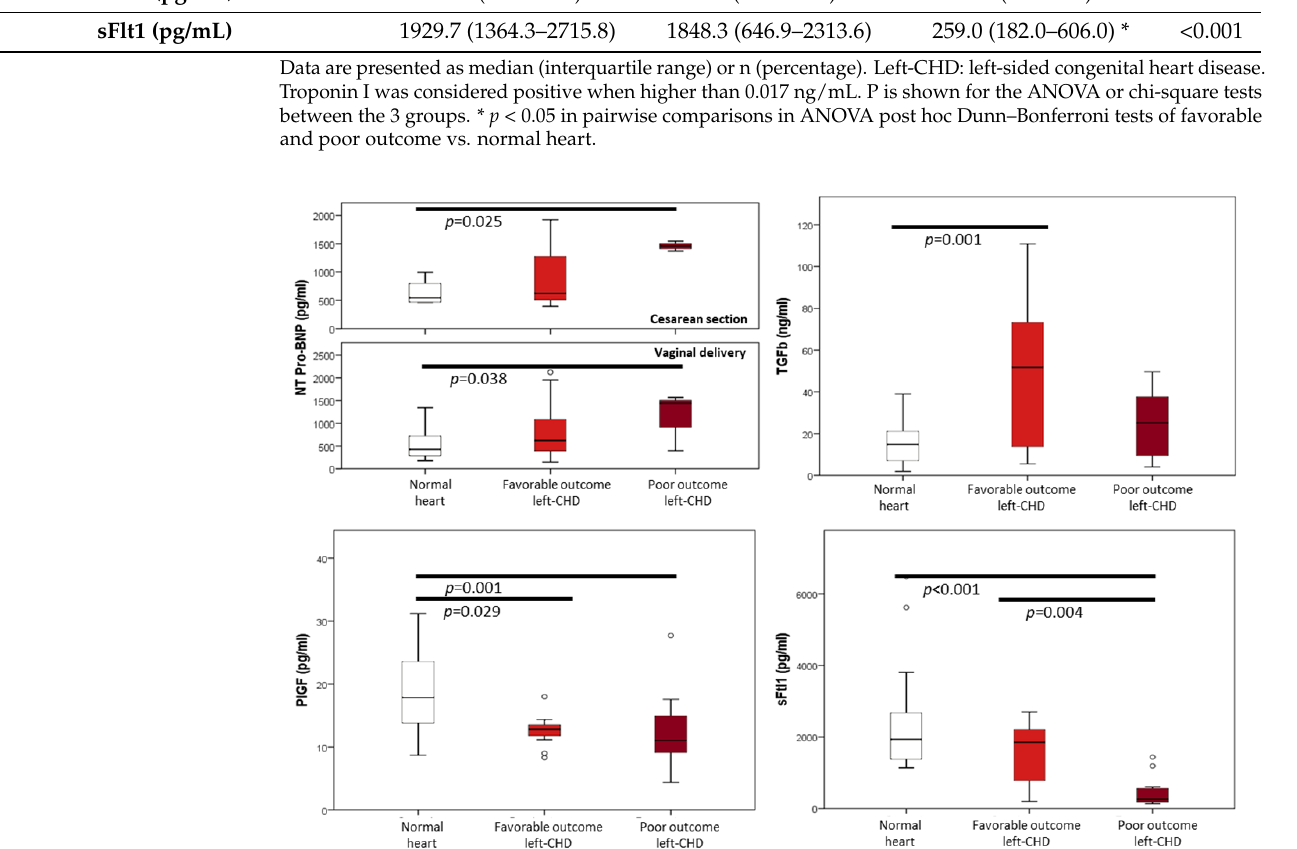
( b ) Figure 3. ( a ) Concentrations of soluble fms-like tyrosine kinase-1 (sFlt1) in the cord blood of control fetuses and fetuses with expected biventricular repair, classified according to outcome (red triangle, favorable outcome; black star, poor outcome. Reference line set at 1520.7 pg/mL identified at ( b )